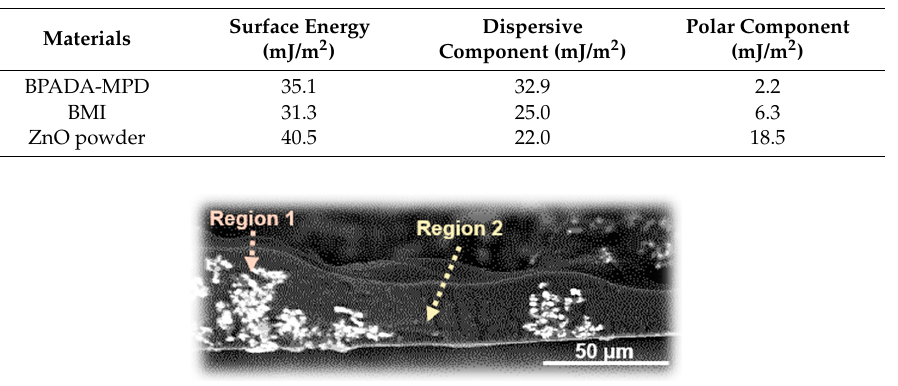
Figure 5. Cross-sectional SEM image of the BMI/copolyimide blend films containing n-ZnO particles (5 vol %). (5 vol